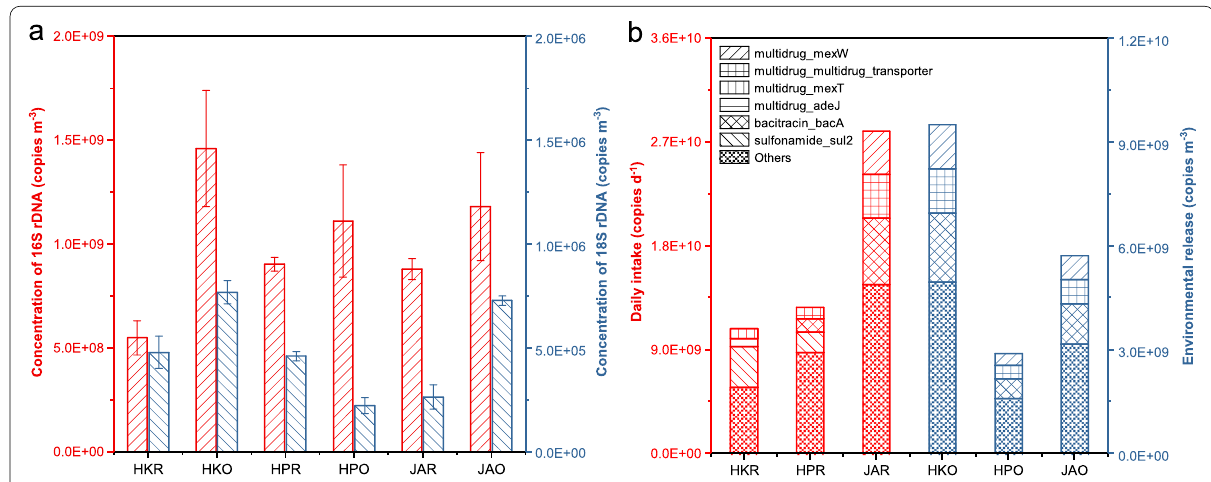
Fig. 8 (a) Concentration (copies m − 3 ) of 16S rDNA and 18S rDNA at six sampling sites (waste reception halls of three transfer stations: HKR, HPR, JAR; top vents of three transfer stations: HKO, KPO, JAO). Red and blue represent 16S rDNA and 18S rDNA, respectively. (b) Daily intake (red) and environmental release (blue) of ARGs, including total ARGs and the three subtypes most affected at each sampling